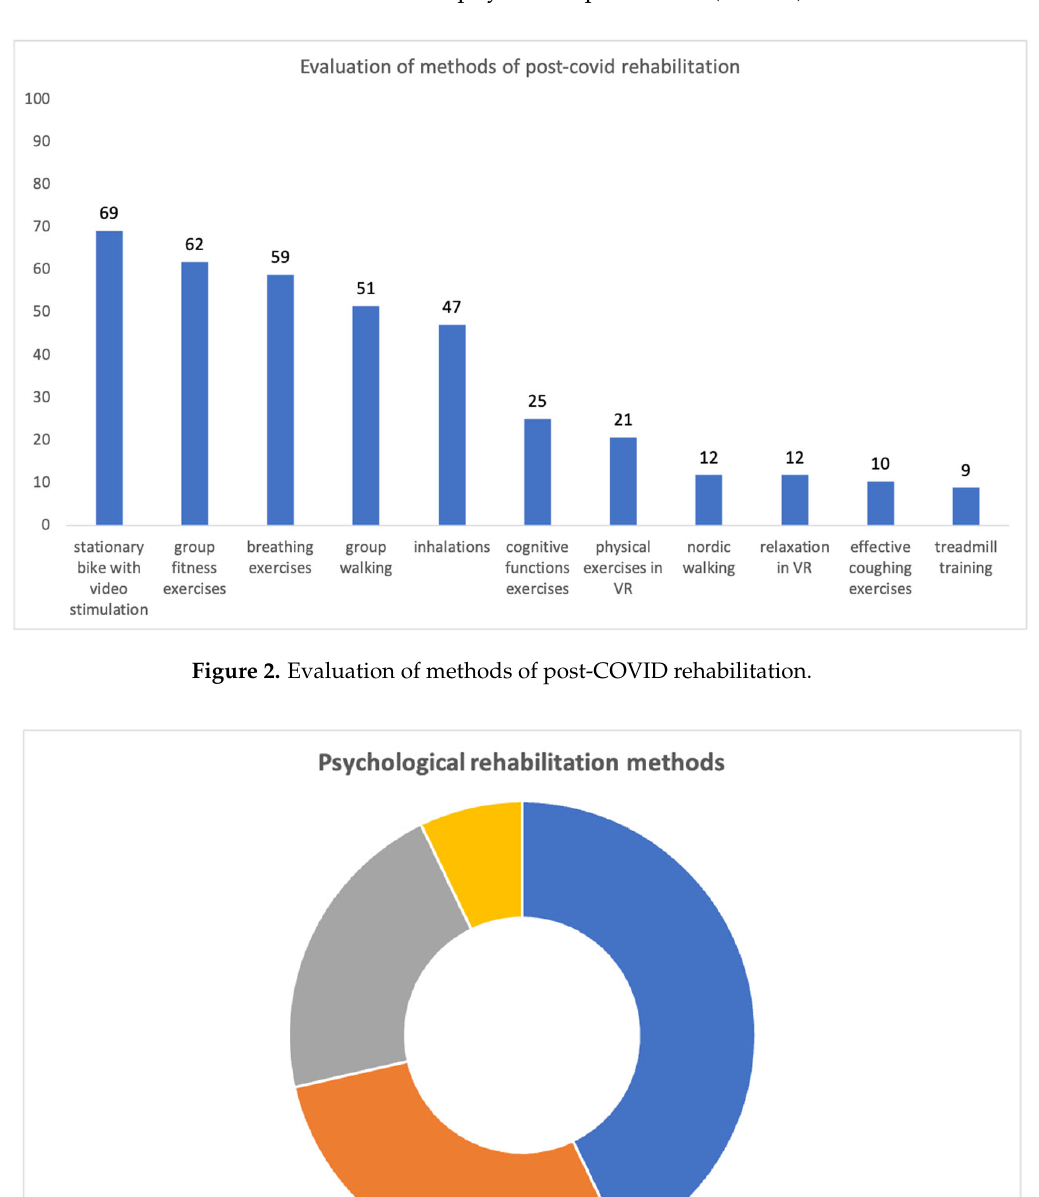
Figure 3. Psychological rehabilitation methods.